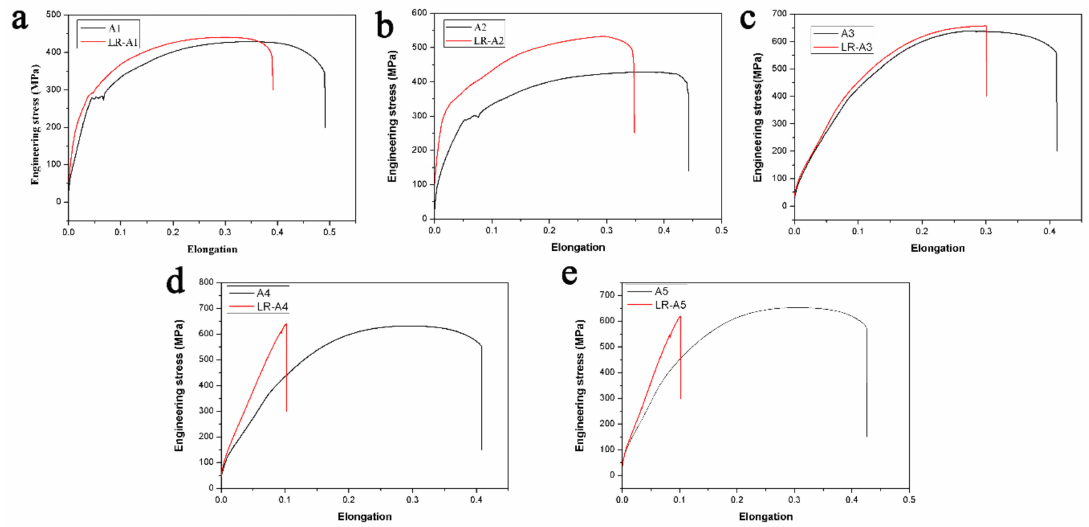
Figure 10. Tensile curves of bionic samples and untreated samples with di ff erent carbon contents: